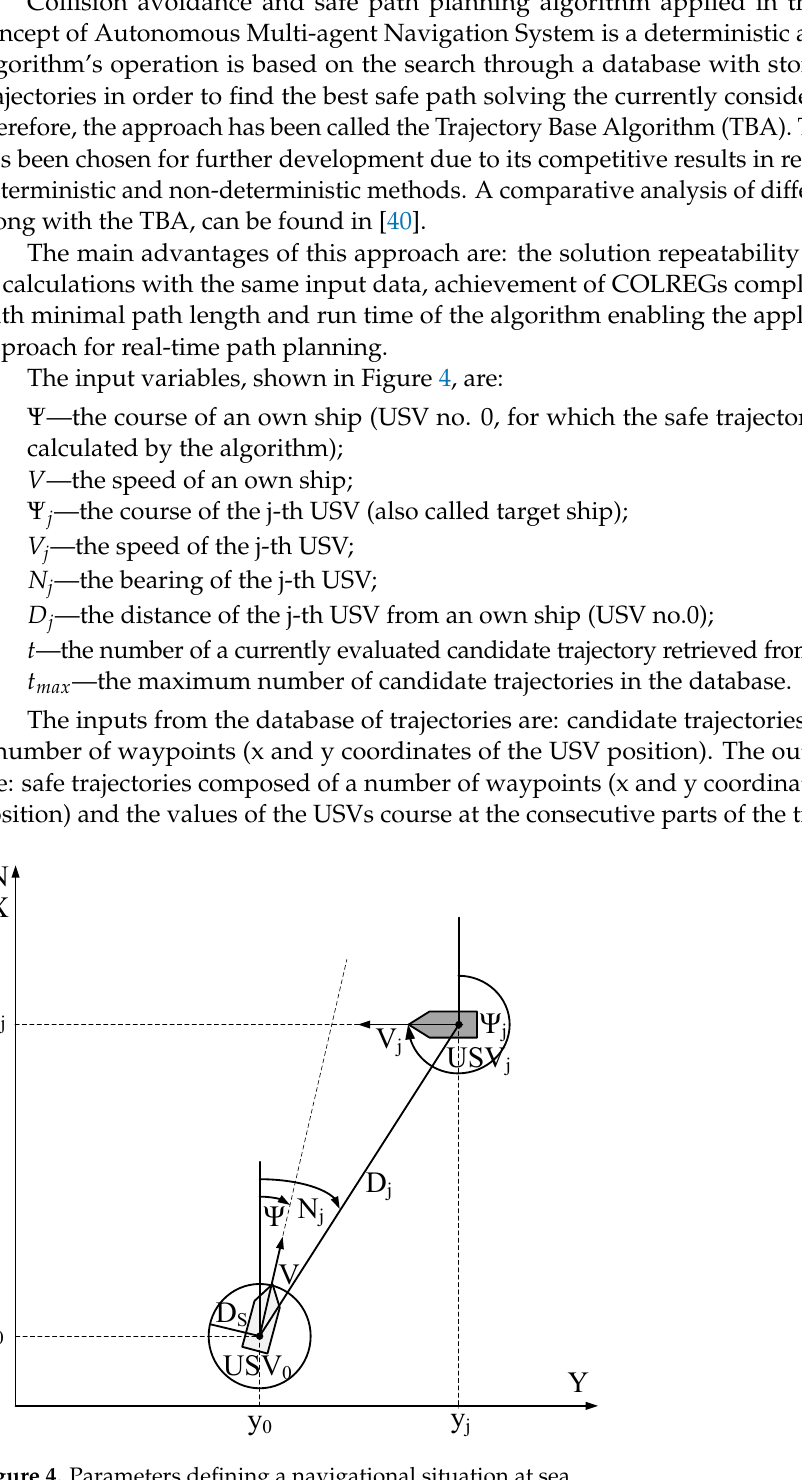
Figure 4. Parameters defining a navigational situation at